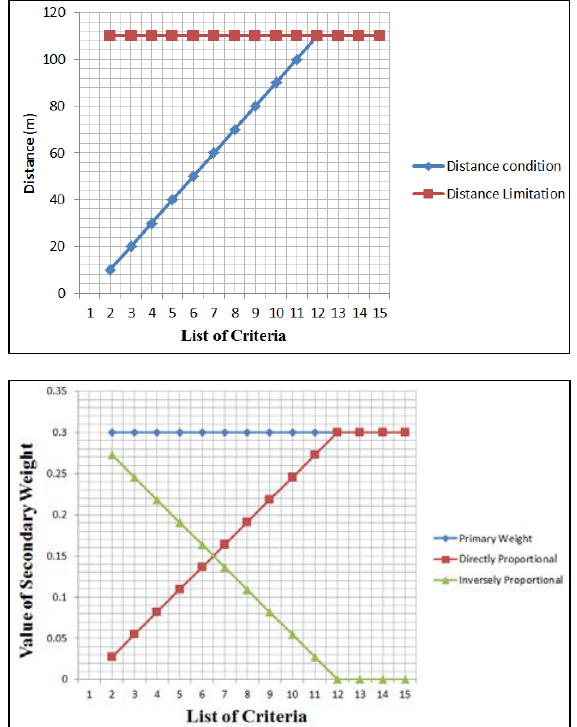
Figure 3. (Above) Fixed Distance Limitations Vs Increasing Distance Condition. (Below) Fixed Primary Weight Vs Results of Directly Proportion and Inversely Proportion of Secondary Weight From the Figure 3, the results of directly proportion and inversely proportion of secondary weights shows that value of distance condition effects the value of secondary weights. As the distance condition reach the value of distance limit, the secondary weight of directly proportion reaches its maximum value while inversely proportion reaches its minimum value.